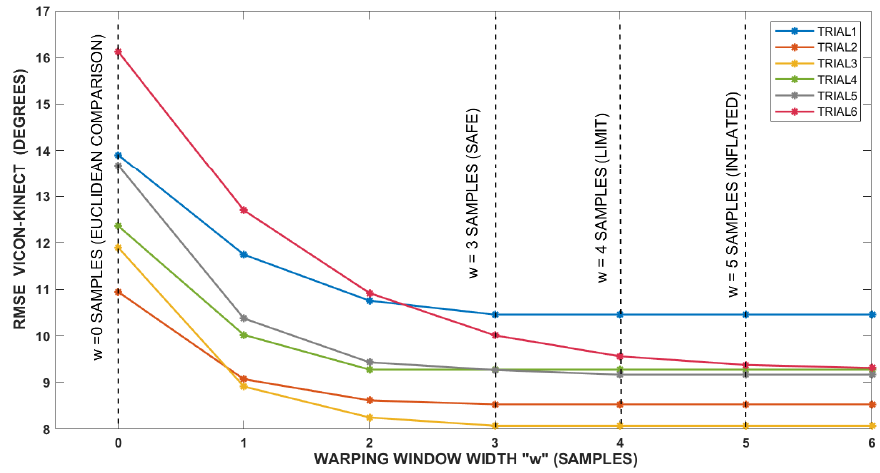
Figure 3. Setting of w parameter (the warping window width).